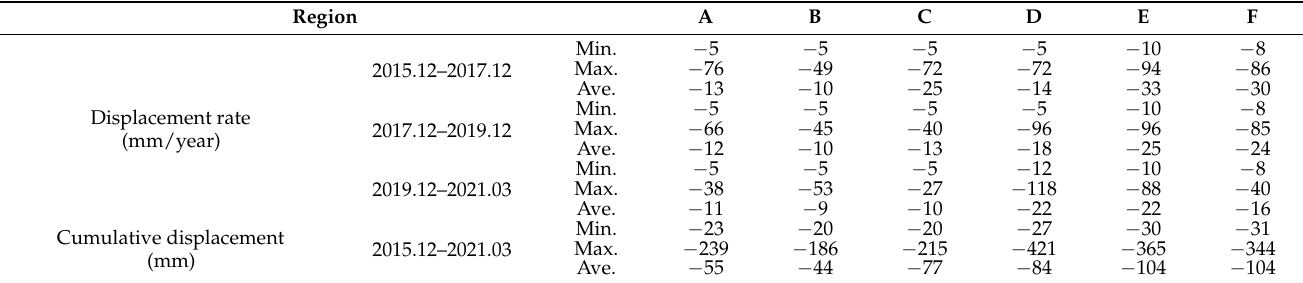
Table 3. Statistics of the surface displacement in Regions A–F, derived from descending Sentinel-1 images. Region A B C